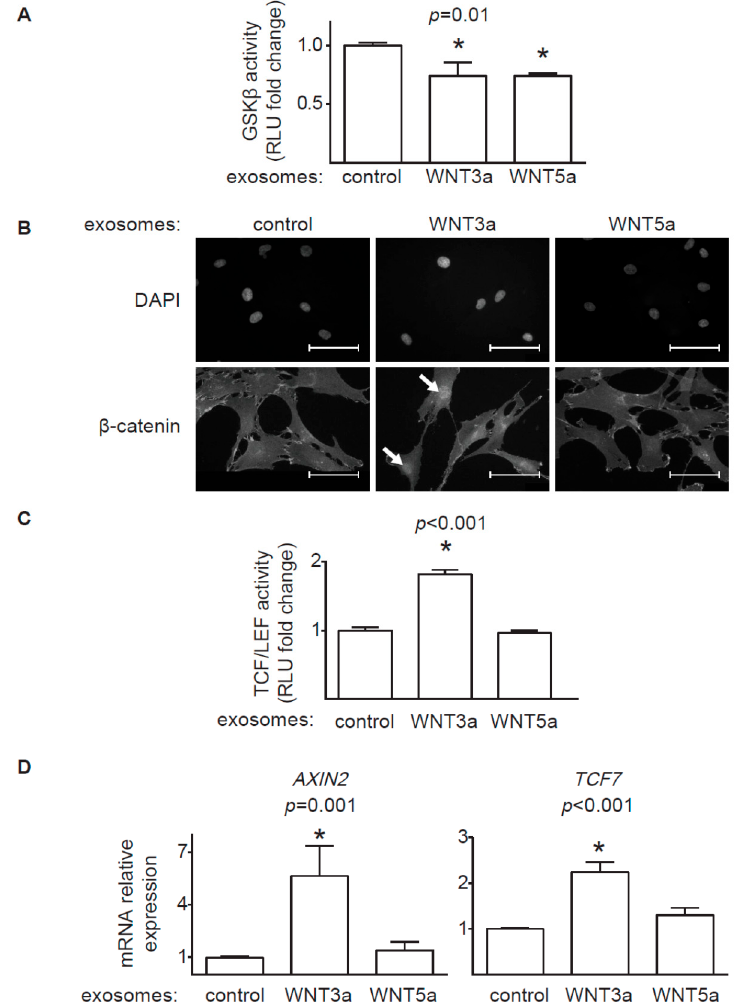
Figure 3. Activation of the canonical WNT/ β -catenin pathway in cardiac fibroblasts. Exosomes obtained from L-WNT3a, L-WNT5a, or control L cells were used to stimulate human cardiac fibroblasts. Panel ( A ) shows quantification of GSK3 β kinase activity in cardiac fibroblasts 1 h after stimulation with exosomes. Graphs show means ± SEM, n = 9, p value computed using one-way ANOVA followed by the Dunnett’s multiple comparisons test, * p < 0.05 (post-hoc test vs control). Panel ( B ) demonstrates localization of β -catenin in cardiac fibroblasts 2 h after treatment with exosomes. DAPI stains cell nuclei. Arrows indicate nuclear localization of β -catenin. Data are representative for three independent experiments. Bar = 50 µm. Panel ( C ) shows quantification of TCF/LEF activity in the TCF/LEF-hCF reporter cardiac fibroblasts stimulated with exosomes for 18 h. Graphs show means ± SEM, n = 14, p values computed using one-way ANOVA followed by the Dunnett’s multiple comparisons test, * p < 0.05 (post-hoc test vs control). Panel ( D ) shows relative mRNA levels of WNT/ β -catenin target genes in cardiac fibroblasts treated with exosomes for 24 h. Graphs show means ± SEM, n = 7, p values computed using the Kruskal–Wallis analysis followed by Dunn’s multiple comparison test, * p < 0.05 (post-hoc test vs control).